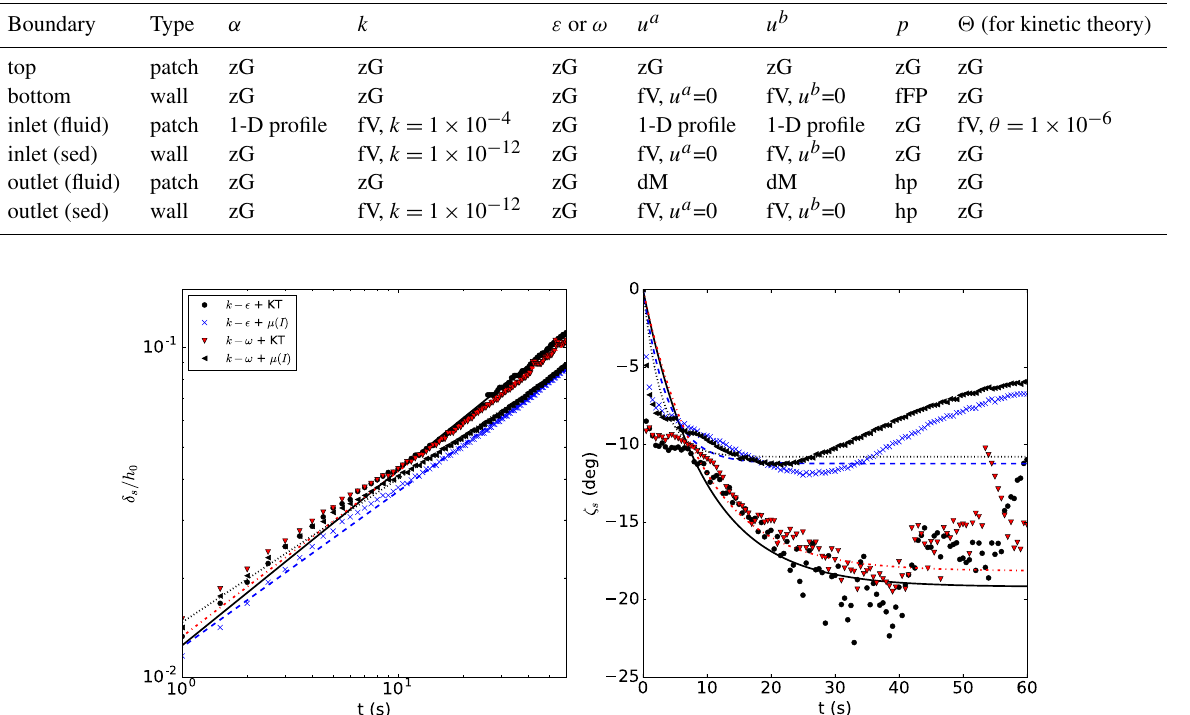
Figure 7. Numerical results for the temporal evolution of the normalized maximum scour depth and upstream bed angle. Different lines represent the best-fit curves for each run for which the parameters are given in Table